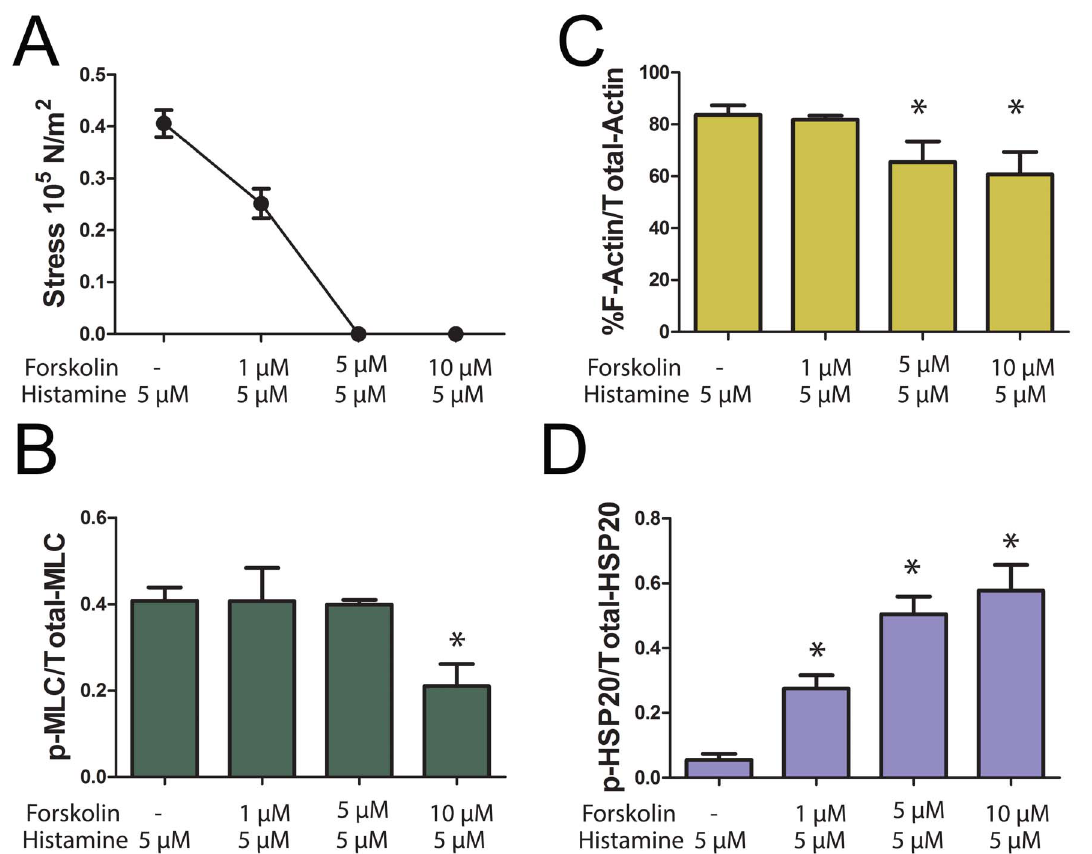
Figure 2. Dose dependent effect of forskolin on force, MLC phosphorylation, F-actin levels and HSP20 phosphorylation during suppression of force. PCA rings were suspended in a muscle bath and equilibrated in Kreb’s bicarbonate buffer for 2 h and rings were pretreated with either nothing, 1, 5, or 10 m M forskolin followed by 5 m M histamine. Force was measured and the tissue was frozen and analysed for MLC phosphorylation, F-actin levels, and HSP20 phosphorylation, Panel A: Cumulative data obtained when the force was converted to stress. Panel B: Cumulative data representing the relative amounts of the p-MLC over the total MLC obtained when the phosphorylated and non-phosphorylated bands were quantitated densitometrically. Panel C: F-actin concentration was calculated and cumulative data is plotted. Panel D: Cumulative data representing the relative amounts of p-HSP20 over total HSP20, obtained when the phosphorylated and non-phosphorylated bands were quantitated densitometrically.